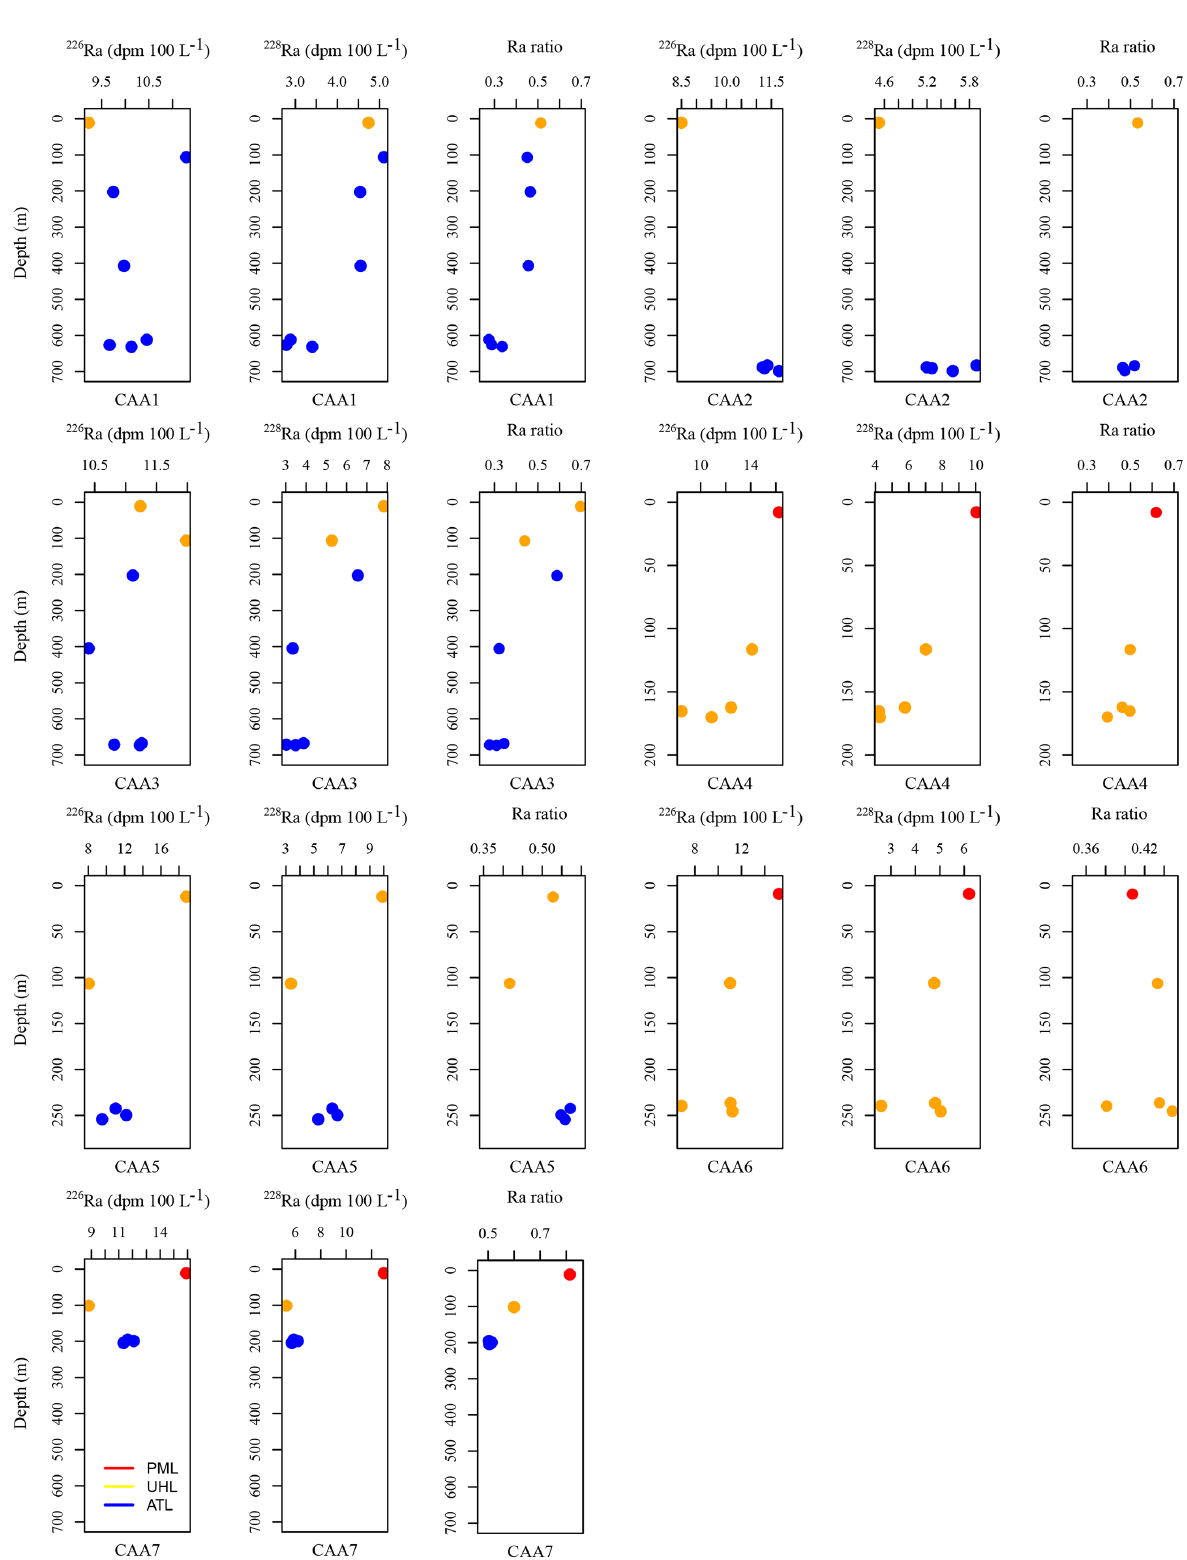
Figure A2. 226 Ra (dpm100L − 1 ), 228 Ra (dpm100L − 1 ), and Ra isotopic ratio ( 228 Ra / 226 Ra) plotted against depth for each station, includ- ing CAA1, CAA2, CAA3, CAA4, CAA5, CAA6, and CAA7, where profiles were taken throughout the 2015 GEOTRACES cruise in the Canadian Arctic Archipelago. Colors indicate the water masses present at the sampled depths: red is the polar mixed layer (PML), yellow is the upper halocline layer (UHL), and blue is the Atlantic layer